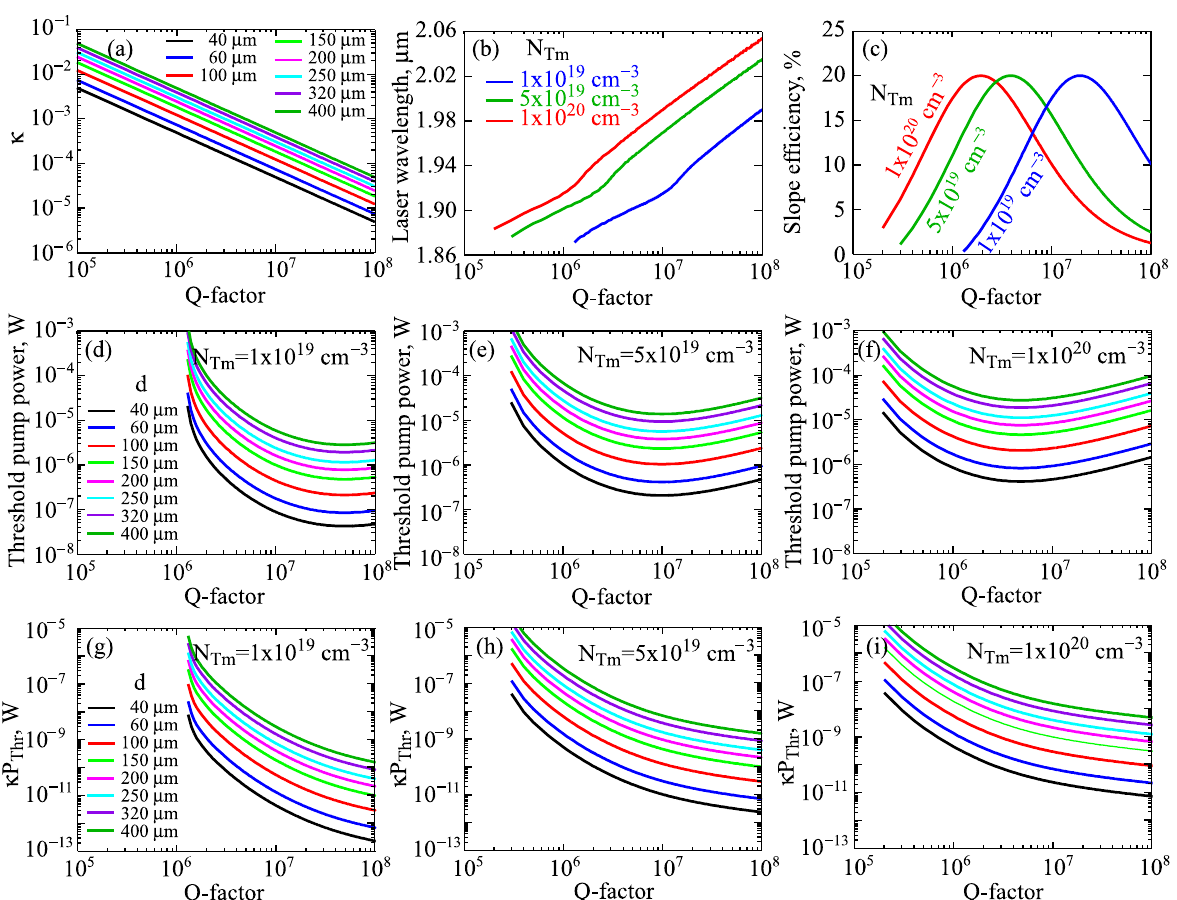
Figure 3. ( a ) Calculated coupling coefficients κ as functions of the total Q-factor for different diameters of tellurite microspheres indicated in the legend. Calculated laser wavelengths ( b ) and slope efficiencies ( c ) above the threshold pump power as functions of the total Q-factor for different thulium ion concentrations N Tm . Threshold pump powers for different microsphere diameters d for thulium ion concentration of 1 · 10 19 cm − 3 ( d ), 5 · 10 19 cm − 3 ( e ), and 1 · 10 20 cm − 3 ( f ). Threshold values of κ P Thr (pump powers multiplied by coupling coefficients) for different microsphere diameters d for thulium ion concentration of 1 · 10 19 cm − 3 ( g ), 5 · 10 19 cm − 3 ( h ), and 1 · 10 20 cm − 3 ( i ). The legend shown in subplots ( d , g ) is the same as for subplots ( d – i ).